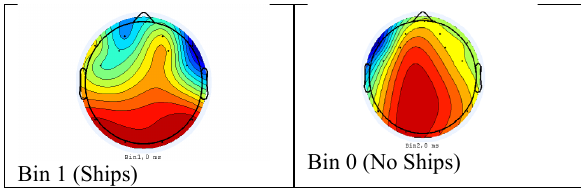
Figure 8. Topographical scalp maps for